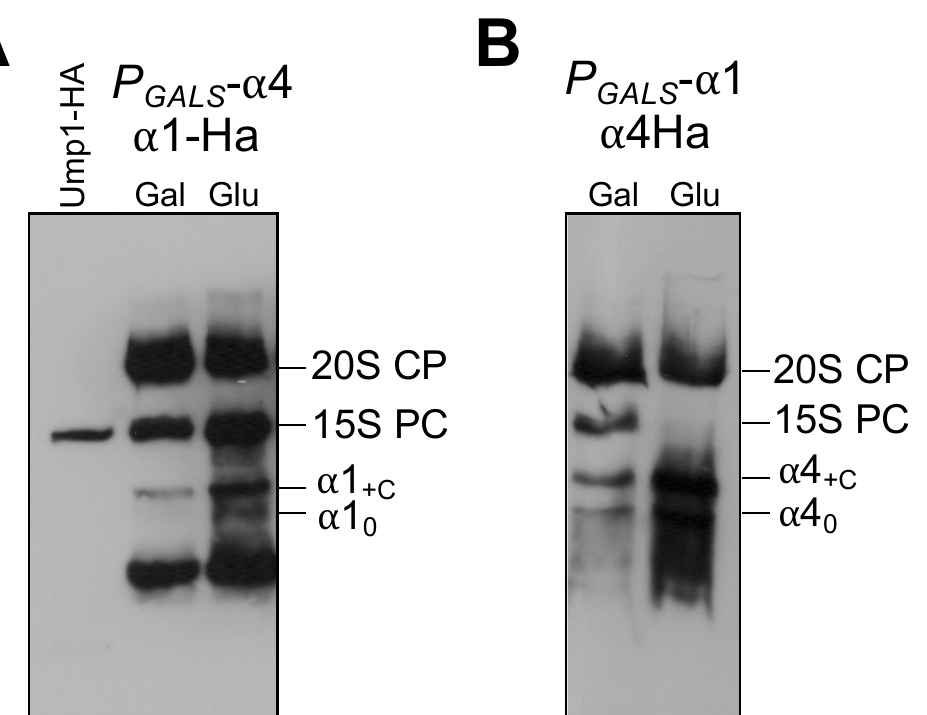
Figure 5. α 1 +C and α 4 +C complexes form independently of each other. ( A ) Cells expressing PRE6 (encoding α 4) from P GALS promoter with α 1-Ha tagged were grown in galactose (Gal) media and switched to glucose (Glu)-containing media for 15 h. Total protein extracts were analyzed by native PAGE and anti-HA immunoblotting. ( B ) same as in ( A ), but with a strain expressing α 1 from P GALS , and with α 4 Ha-tagged.